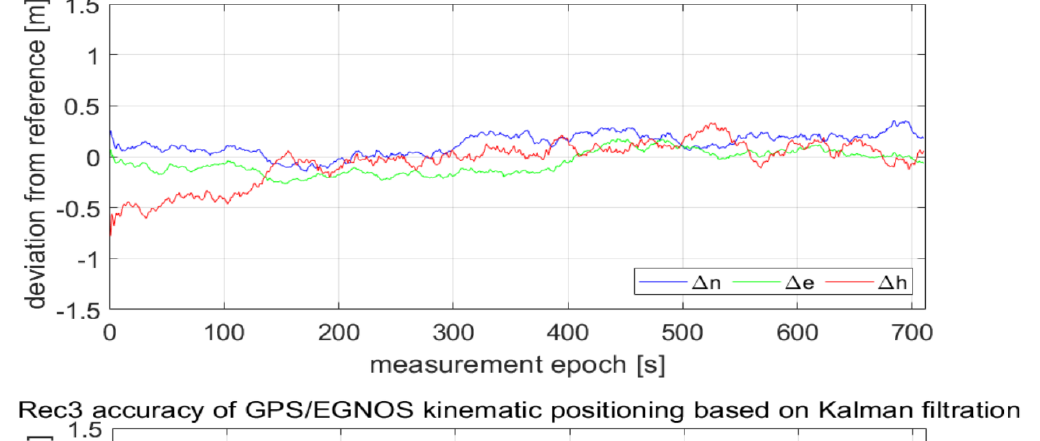
Figure 5. Accuracy of the vertical coordinate of EGNOS positioning for three mobile receivers in initial measurement time span together with Kalman filtering. In such a situation, the values ∆𝑛 𝑉 , ∆𝑒 𝑉 , ∆ℎ 𝑉 calculated on the basis of formula (21) would have an independent and reliable validation of SBAS positioning, in their character. In the test calculations, only GPS satellites were used, since at present, the EGNOS data contain corrections for the GPS system only. The results of the GPS/EGNOS system validation, based on three receivers, are depicted in Figure 6.